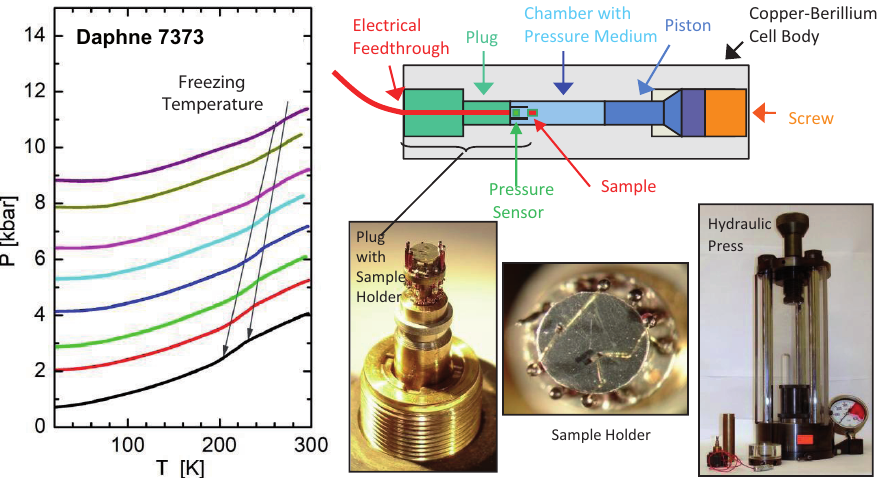
Figure 8. Left panel: Pressure loss of Daphne 7373 oil during cooling; the arrows mark the temperature range of freezing. The data were recorded in a Copper-Berrilium cell by four-point resistance measurement of an InSb pressure sensor. Right panel: Sketch of the actual pressure cell used and photos of the sample holder, and the hydraulic